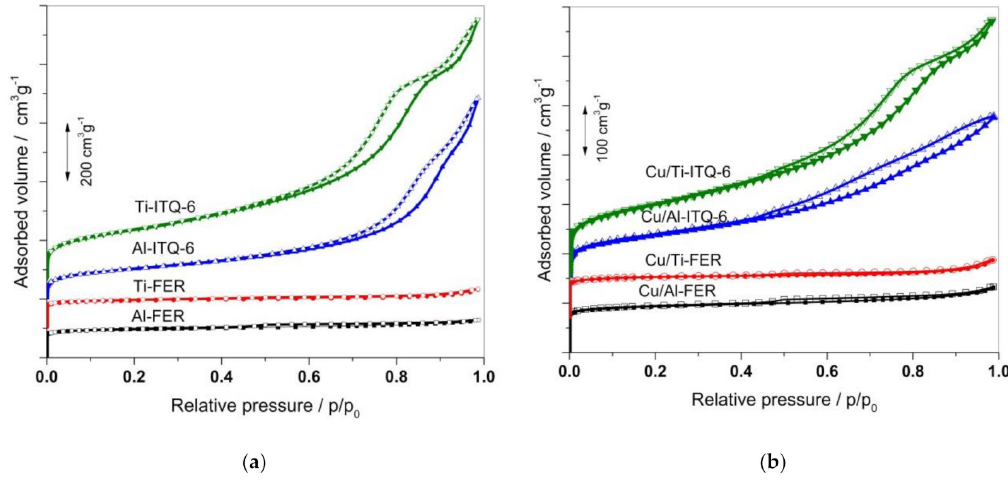
Figure 2. Dinitrogen isotherms recorded for Al- and Ti-containing zeolite samples ( a ) and their Cu-modified forms ( b